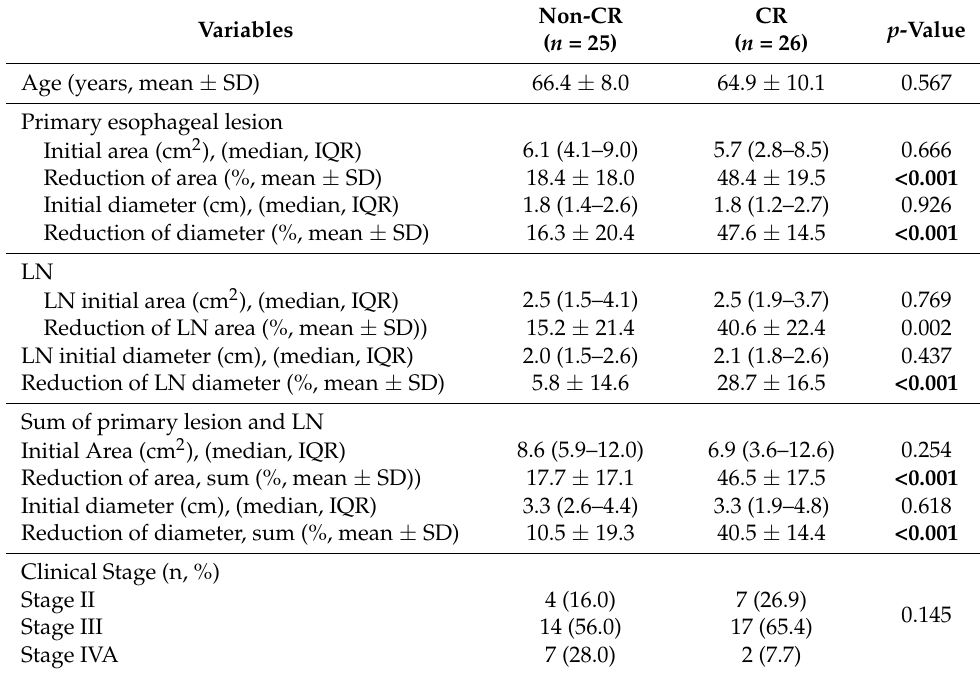
Table 3. Factors associated with complete response